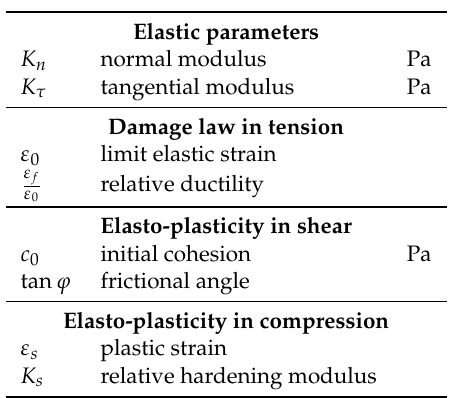
Table 1. Summary of the model parameters required in calibration of the Discrete Element Method (DEM)